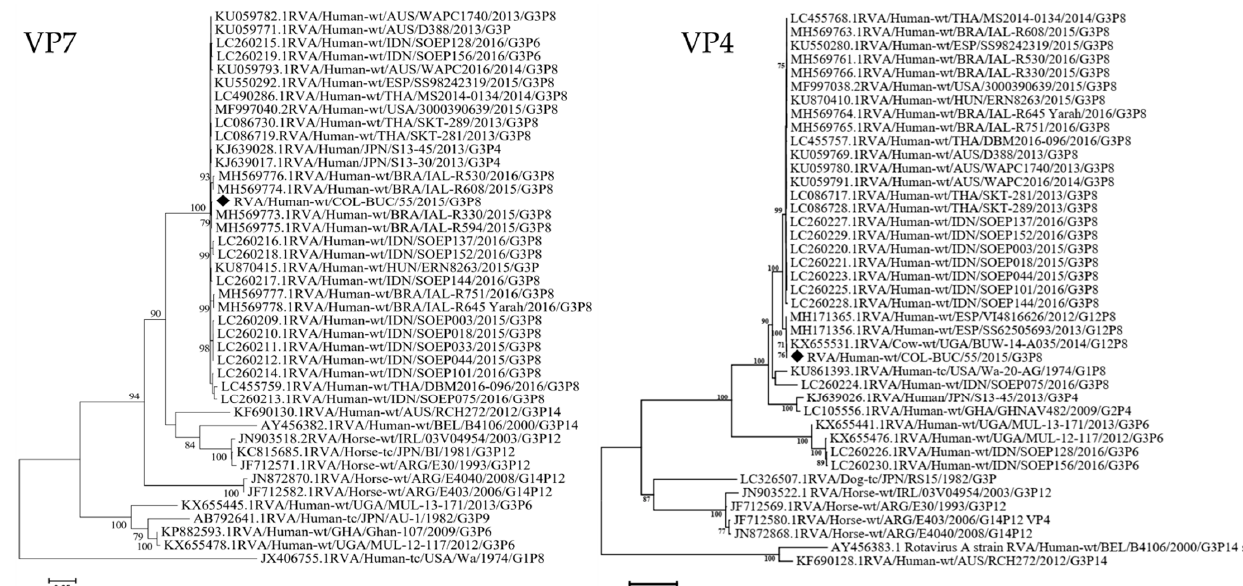
Figure 1. RVA VP7 (G)/VP4 [P] Maximum Likelihood Phylogeny. The trees with the highest log likelihood are shown. The percentage of trees in which the associated taxa clustered together is shown next to the branches. The tree is drawn to scale, with branch lengths measured in the number of substitutions per site. All positions containing gaps and missing data were eliminated. Bootstrap values lower than 70% are not shown. Black Diamonds ( ) indicate the Colombian G3P[8] strain in this study compared with other representative human and animal strains from the GenBank database. Evolutionary analyses were conducted in MEGA7.